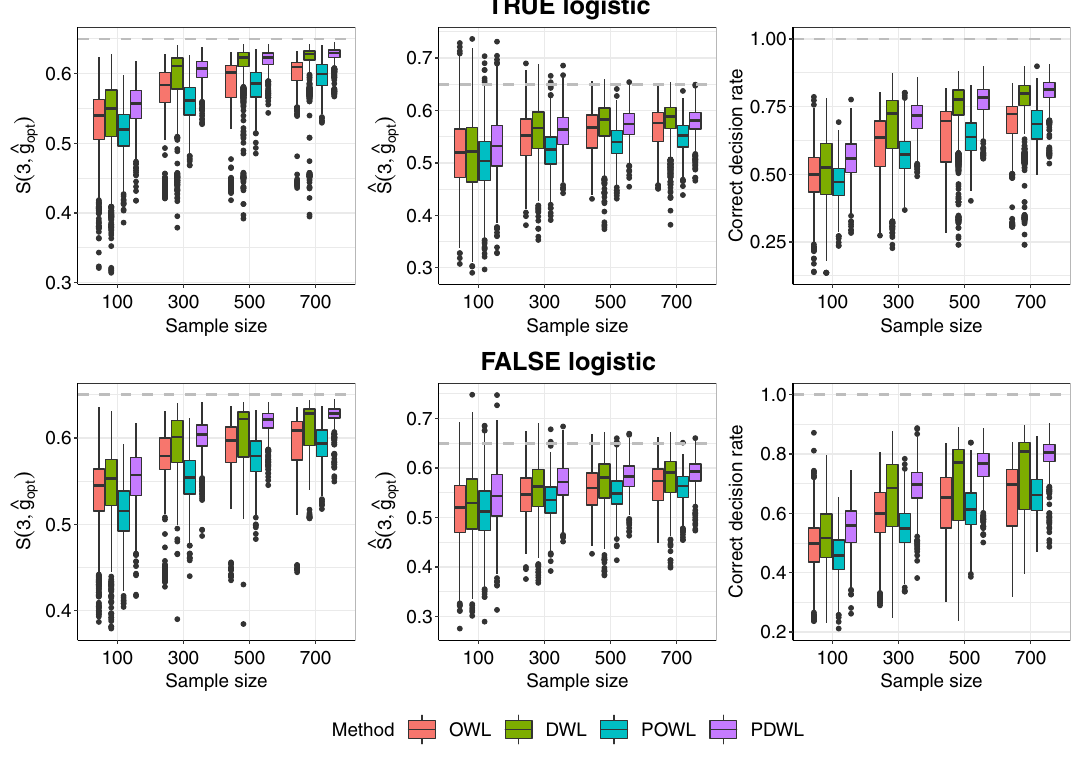
Figure 1. Survival probability and average correct decision rate (ACDR) of two stages under optimal dynamic treatment regimes with OWL, DWL, POWL and PDWL for different sample sizes. Optimal regimes should maximize the survival rate and